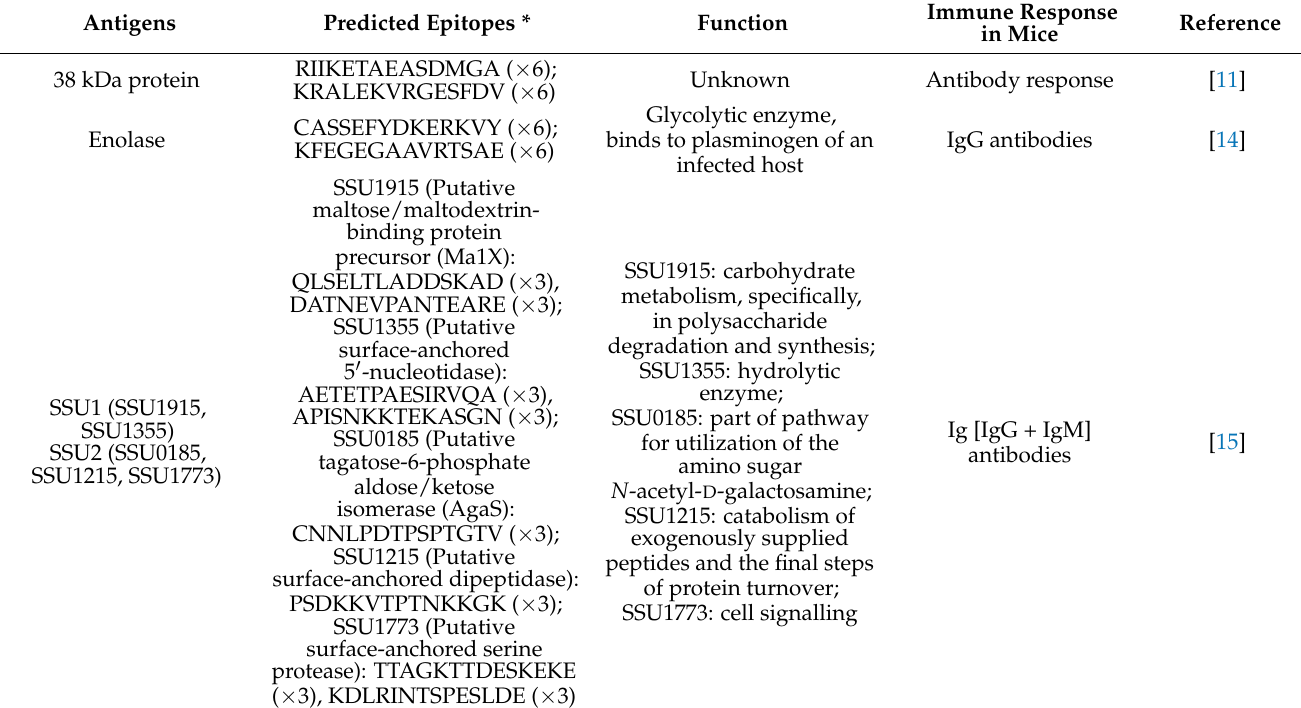
Table 1. Antigens and predicted epitopes for design of 38-BP-Enol and SSU1-BP-SSU2 particulate vaccines.